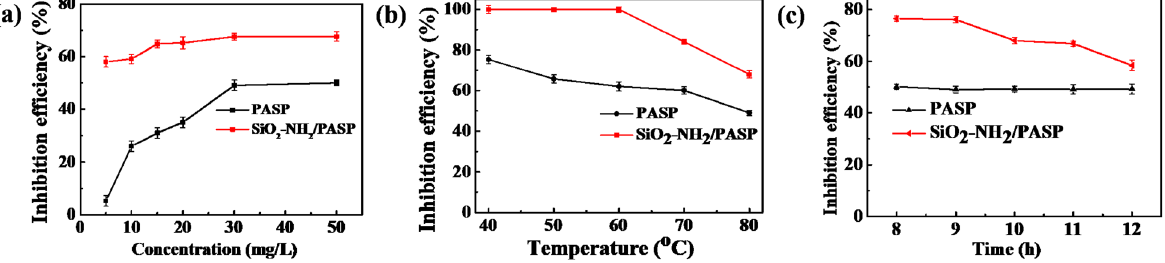
Fig. 4 Inhibition ef fi ciency of PASP and SiO 2 – NH 2 /PASP against CaCO 3 scale. a Different inhibitor concentration, b different test temperature, c different test time. Error bars indicate the standard